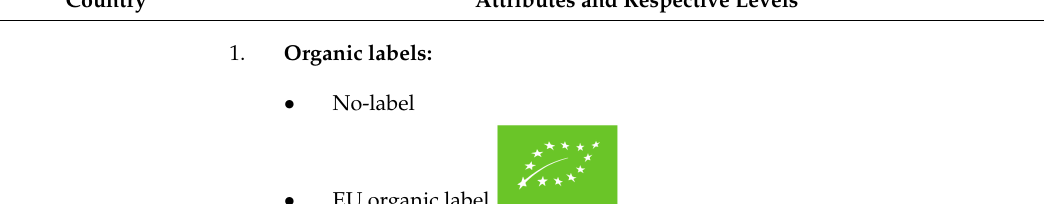
Table 1. Attributes and respective levels used in the choice experiment. Country Attributes and Respective